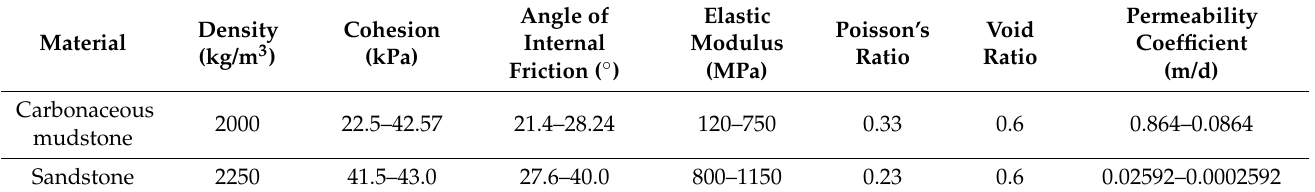
Table 1. Material properties of the studied slope.